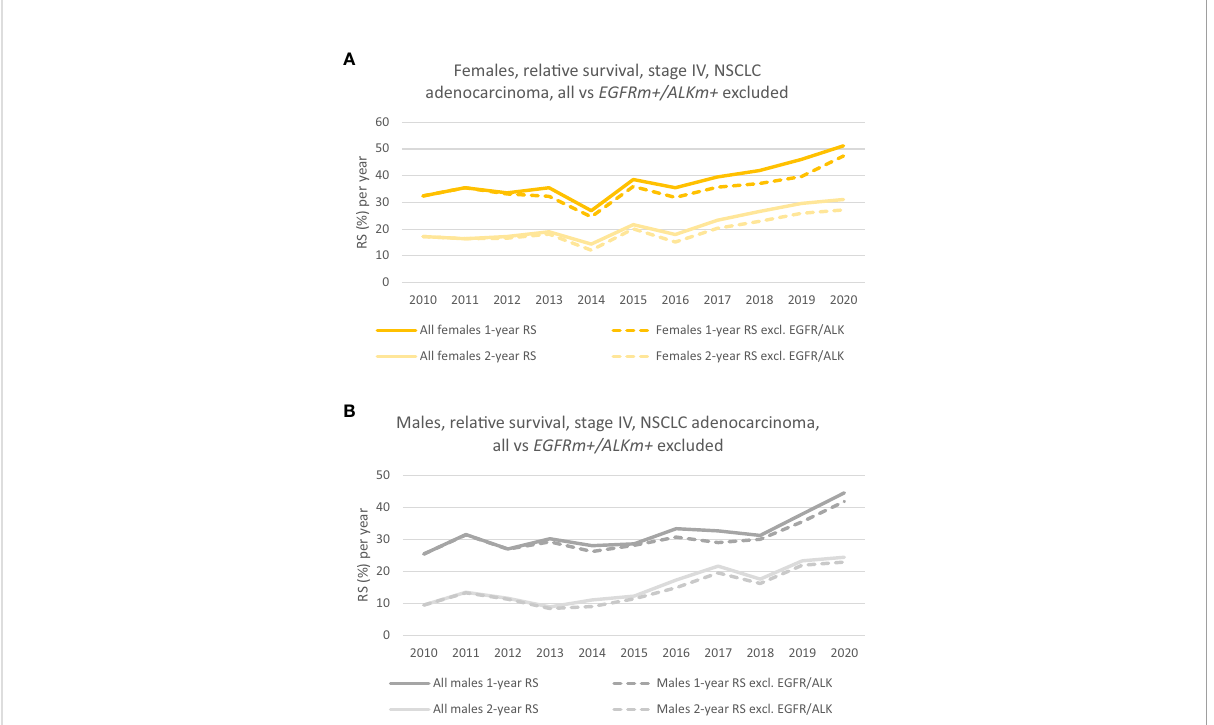
FIGURE 3 (A) 1- and 2-year relative survival of females, where patients with EGFRm+/ALKm+ are excluded from the analysis (dotted lines). (Solid lines show the corresponding 1 -and 2-year RS for the group where patients with driver mutations were included). (B) 1- and 2-year relative survival of males where patients with EGFRm+/ALKm+ are excluded from the analysis (dotted lines). (Solid lines show the corresponding 1 -and 2-year RS for the group where patients with driver mutations were